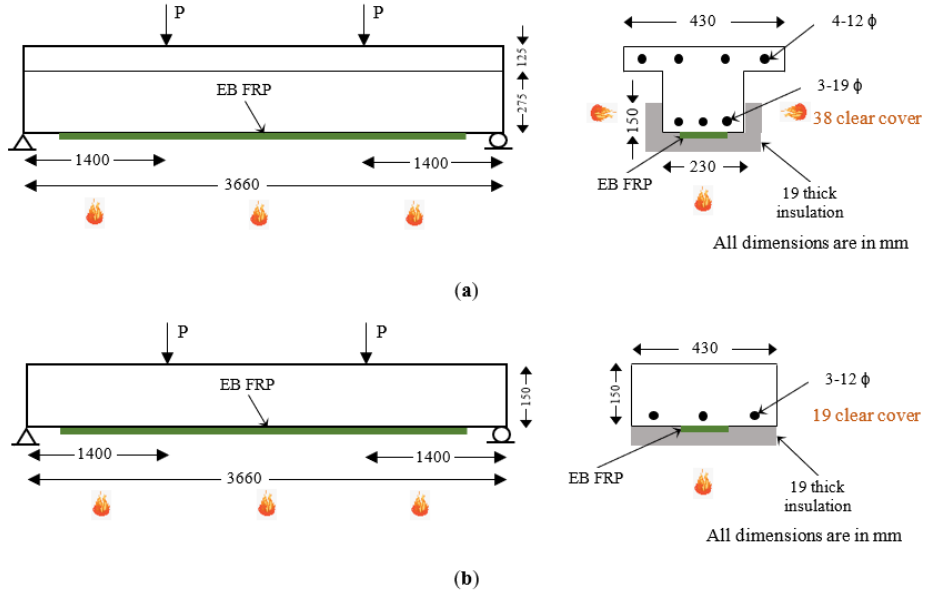
Figure 3. Layout and geometric details of RC members strengthened with NSM-type FRP reinforce- ment. ( a ) RC T-beam strengthened with NSM FRP reinforcement; ( b ) RC slab strengthened with NSM FRP reinforcement.